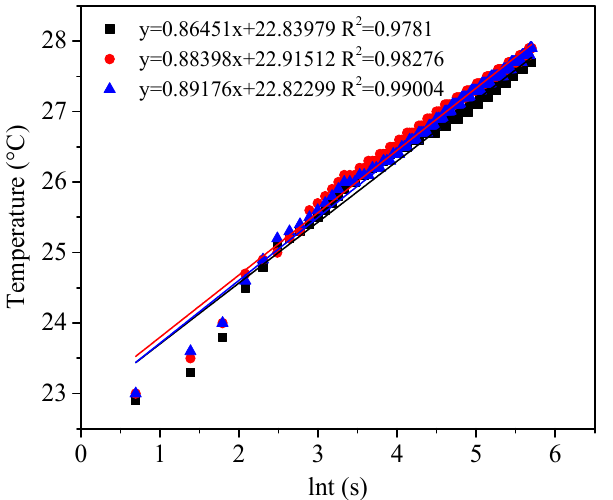
Figure 8. Evaluation of thermal conductivities of aerogel powder by transient hot-wire method.